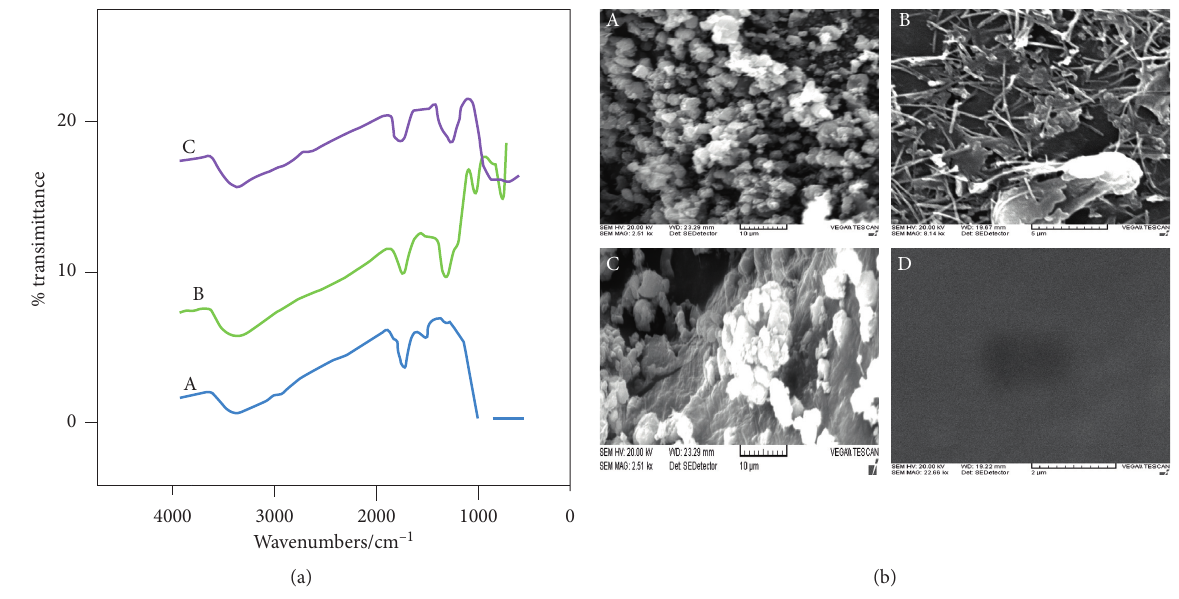
Figure 1: (a) FT-IR; (b) SEM images for (a) TiO 2 and (b) GNR; (c) TiO 2 /GNR nanocomposite; (d)